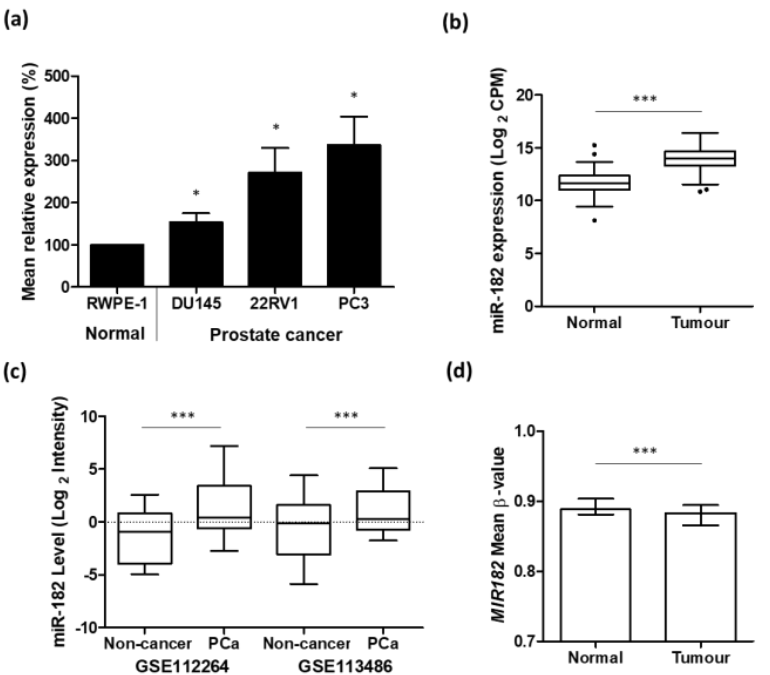
Figure 1. Up-regulation of miR-182 is associated with prostate cancer. ( a ) qRT-PCR shows relative mean miR-182 expression in DU145, 22RV1, and PC3 prostate cancer cell lines is significantly higher than that in normal prostate cell-line, RWPE-1 ( n = 4, housekeeping: Snord48) (unpaired t -test, * p < 0.05). ( b ) UCSC Xena analysis of TCGA PRAD samples shows miR-182 expression is significantly increased in prostate tumor tissue ( n = 494) compared to normal prostate tissue ( n = 52). (Welch’s t -test *** p < 0.001). ( c ) miR-182 is significantly elevated in the serum of prostate cancer patients compared to healthy, non-cancer control patients. Data from GEO datasets GSE112264 ( n , Non-cancer = 41, PCa = 809) and GSE113486 ( n , Non-cancer = 100, PCa = 40). (One-way ANOVA with multiple comparison tests, *** p < 0.001). ( d ) Mean β -value methylation of 7 CpG sites in MIR182 promoter region is significantly reduced in prostate tumor tissue ( n = 431) compared with normal prostate tissue ( n = 33). Wilcoxon paired test, *** p < 0.001. Graph generated from UCSC Xena analysis of TCGA PRAD Illumina 450 K methylation array data. Bars show median and interquartile range. CPM = Counts per million; n = number; PCa = prostate cancer. Table 1. Functional enrichment analysis of miR-182 in prostate cancer. Table shows the significant association of miR-182 target genes with Gene Set descriptions related to prostate cancer. Analysis performed using clusterProfiler in CancerMIRNome.